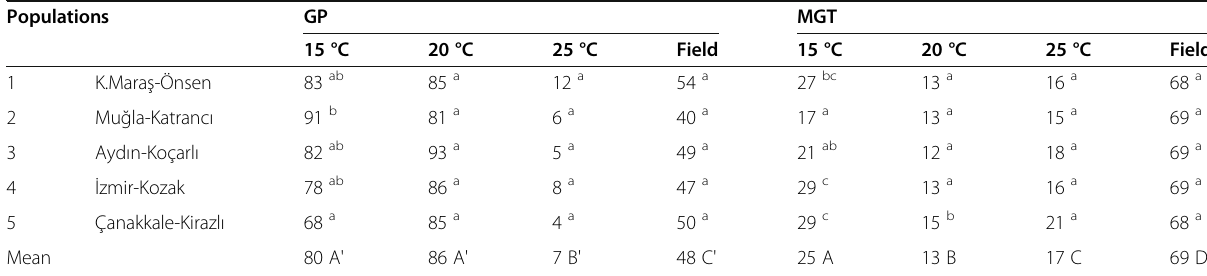
Table 4 Germination of P . pinea seeds from five natural populations at 15, 20, and 25 °C and in the field Populations GP MGT 15 °C 20 °C 25 °C